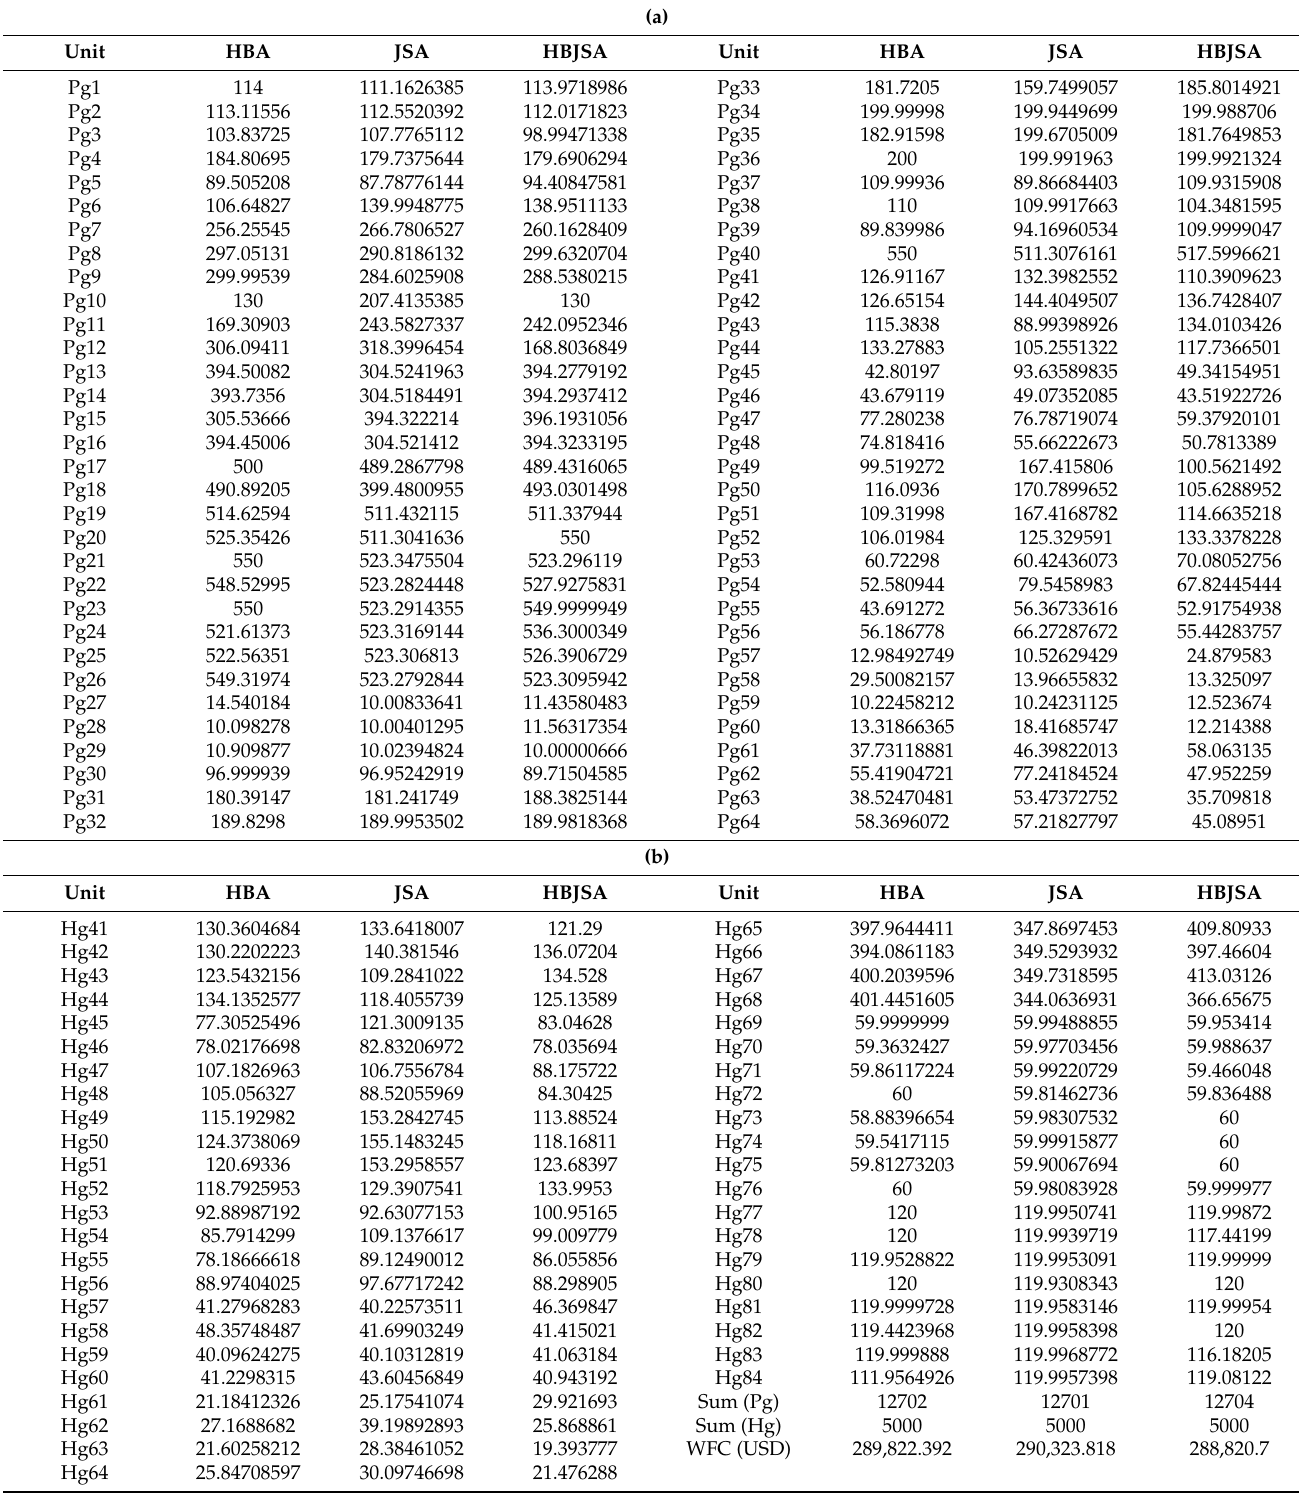
Table 5. Comparison between HBA, JSA, and the proposed HBJSA for the 84-unit test system of CHP economic